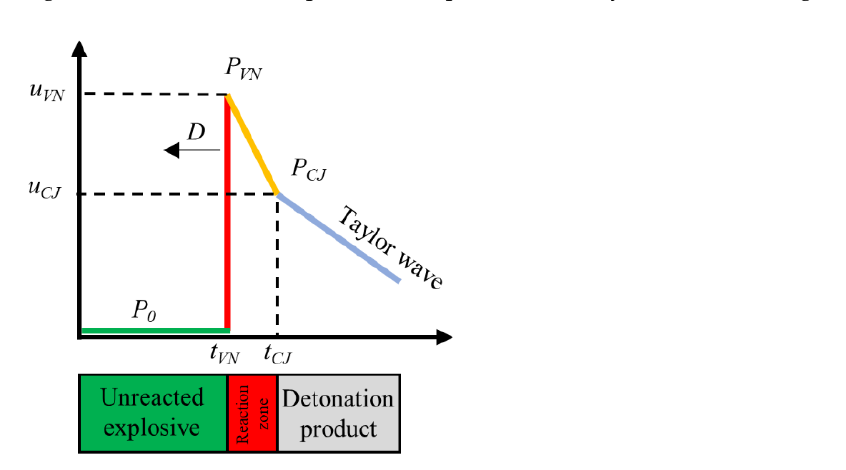
Figure 4. Typical particle-velocity profile ( above ) and schematic of ZND model ( below ).